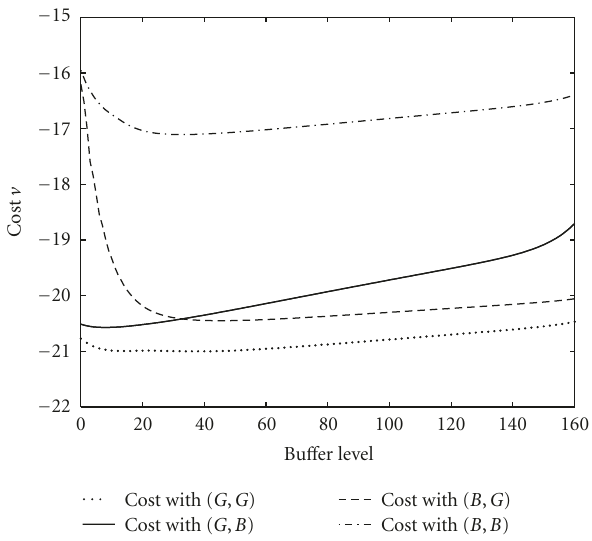
Figure 6: The shape of the cost versus bu ff er load (with optimal rate and power